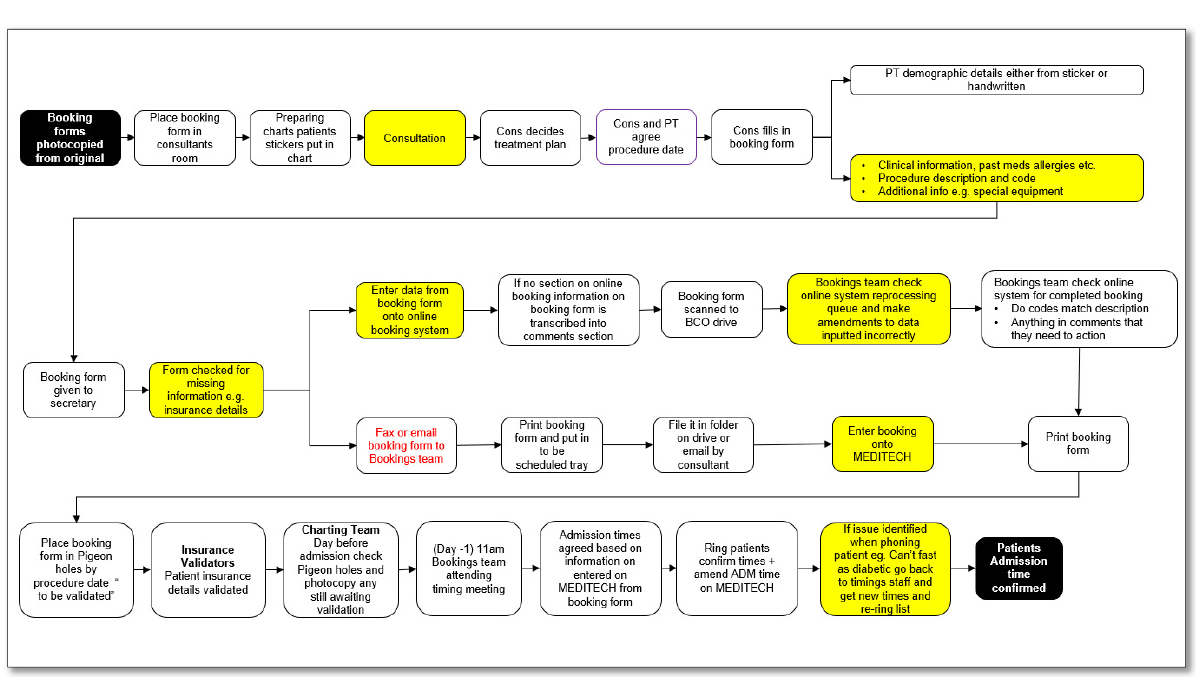
Figure 3. “ As it is processed” map. Figure 3. “As it is processed”